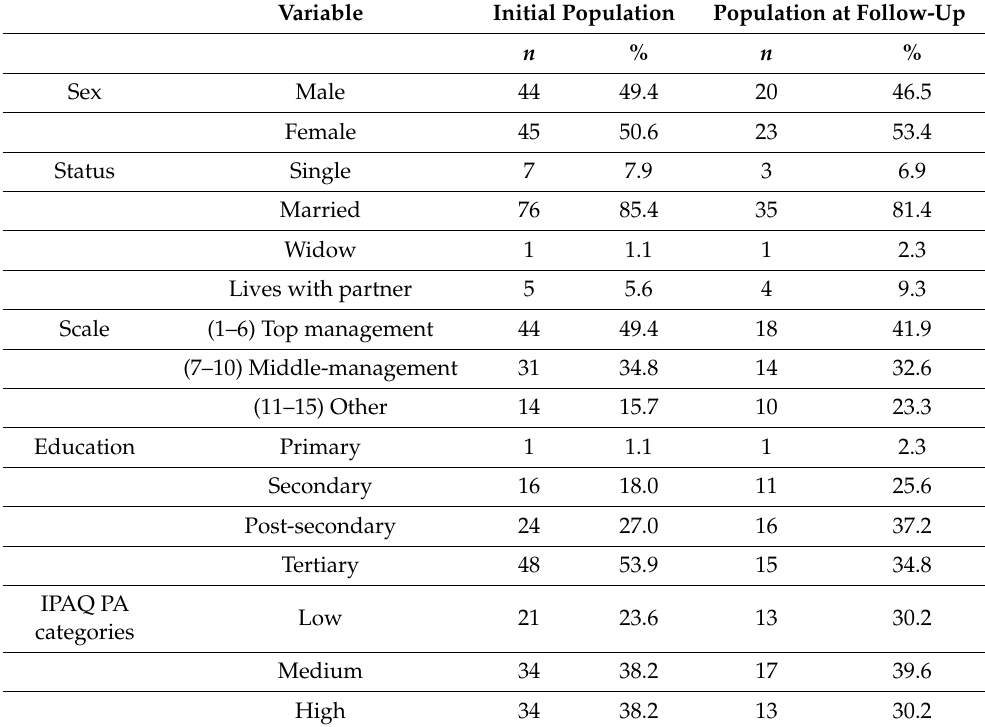
Table 1. Demographic description of the population. Variable Initial Population Population at